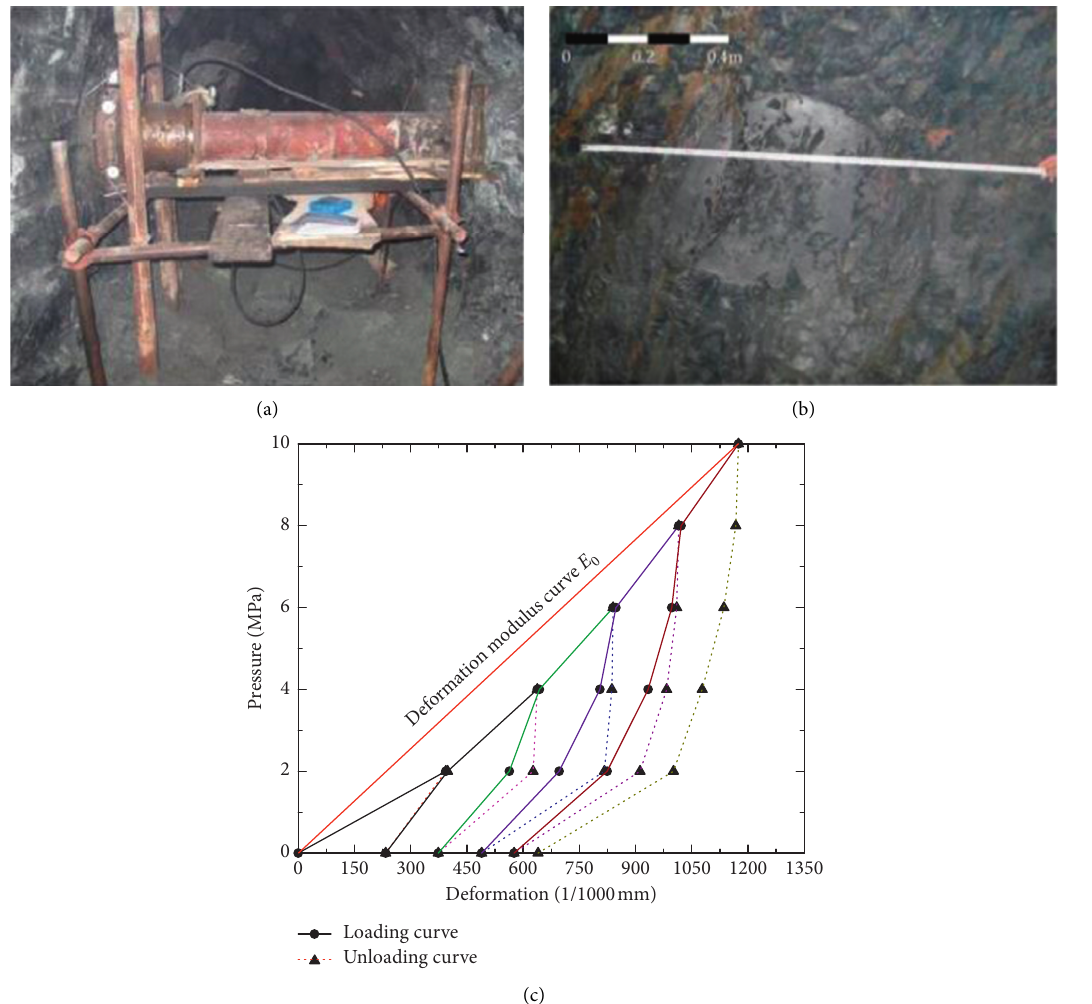
Figure 5: In situ rigid bearing plate tests on columnar jointed basalts (CJB): (a) bearing plate test equipment installation; (b) deformation of columnar basalts [16]; (c) pressure-deformation curves of rigid bearing plate